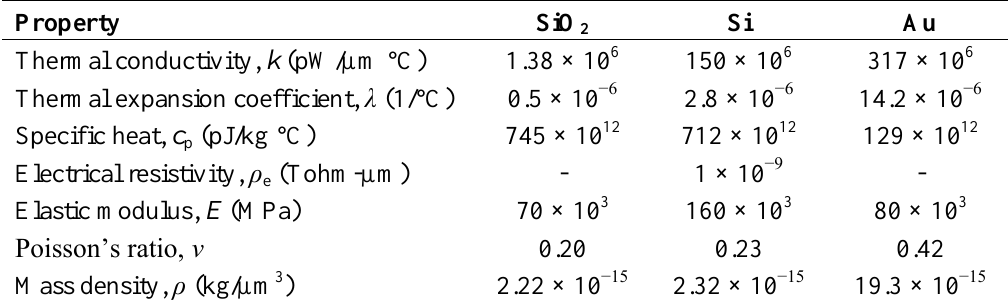
Table 1. Material properties of doped microcantilevers in µMKS